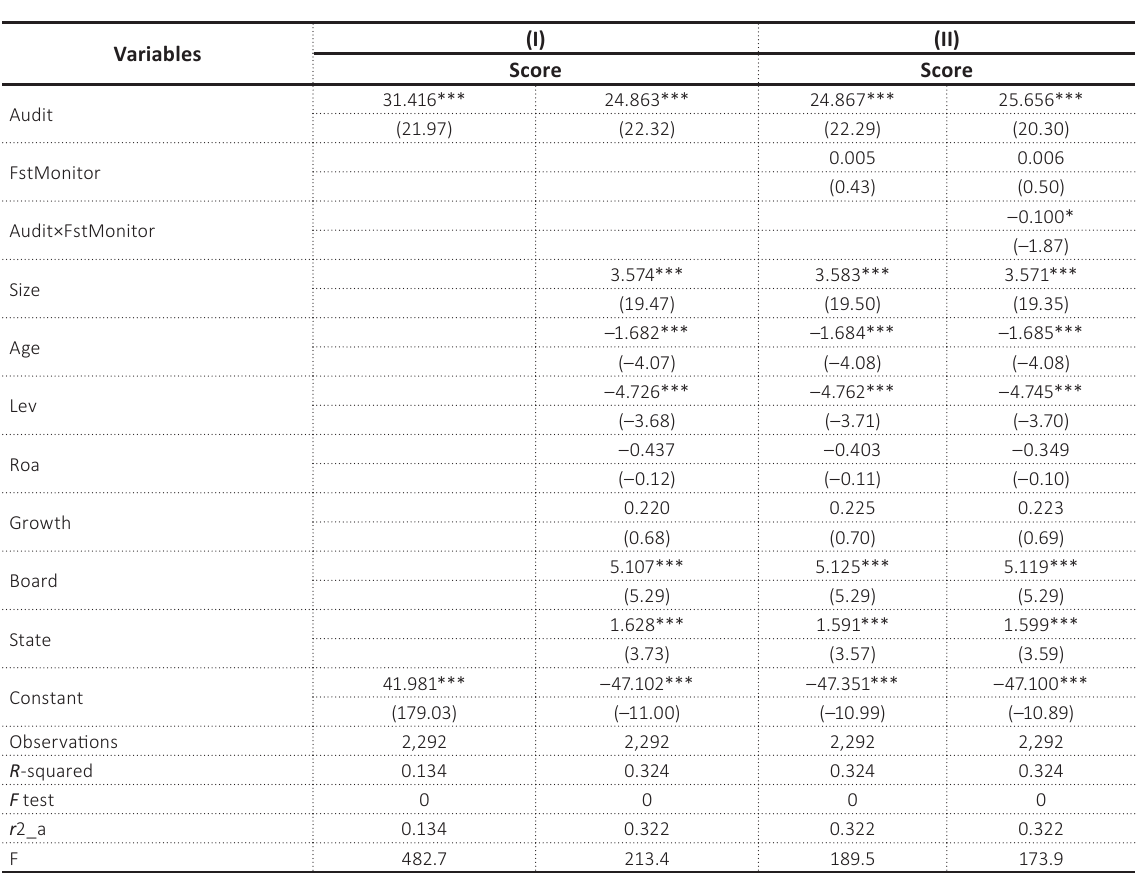
Table A3. Regression analysis